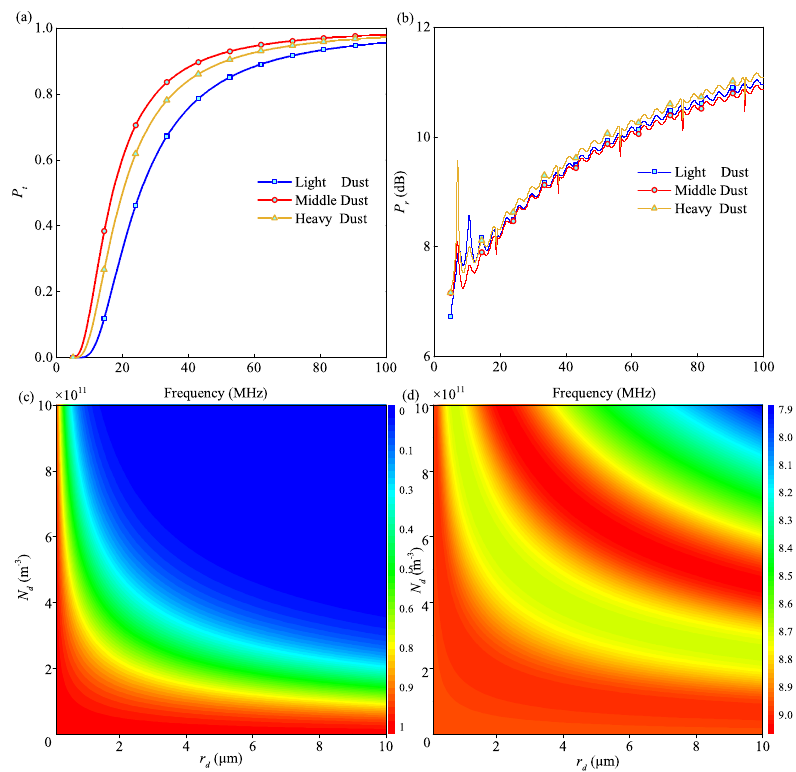
Figure 5. ( a ) P t and ( b ) P r versus wave frequency under three dust characteristics; ( c ) P t and ( d ) P r under dust characteristics of density and